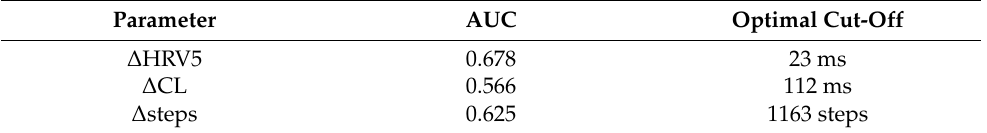
Table 4. Area under the receiver operating curve (AUC) and optimal threshold for the change in